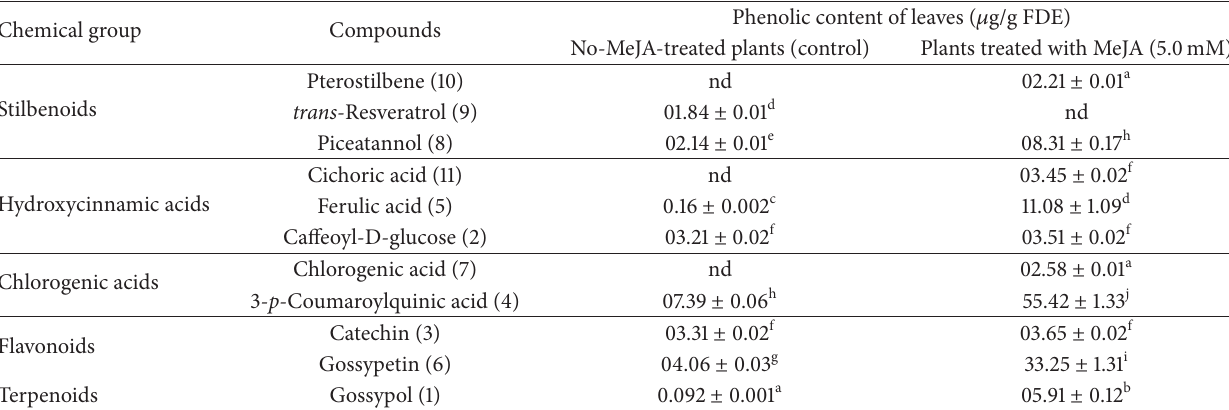
Table 2: Phenolic composition of cotton leaves treated with methyl jasmonate at 72 h posttreatment. Phenolic content of leaves ( 𝜇 g/g FDE) Chemical group Compounds No-MeJA-treated plants (control) Plants treated with MeJA